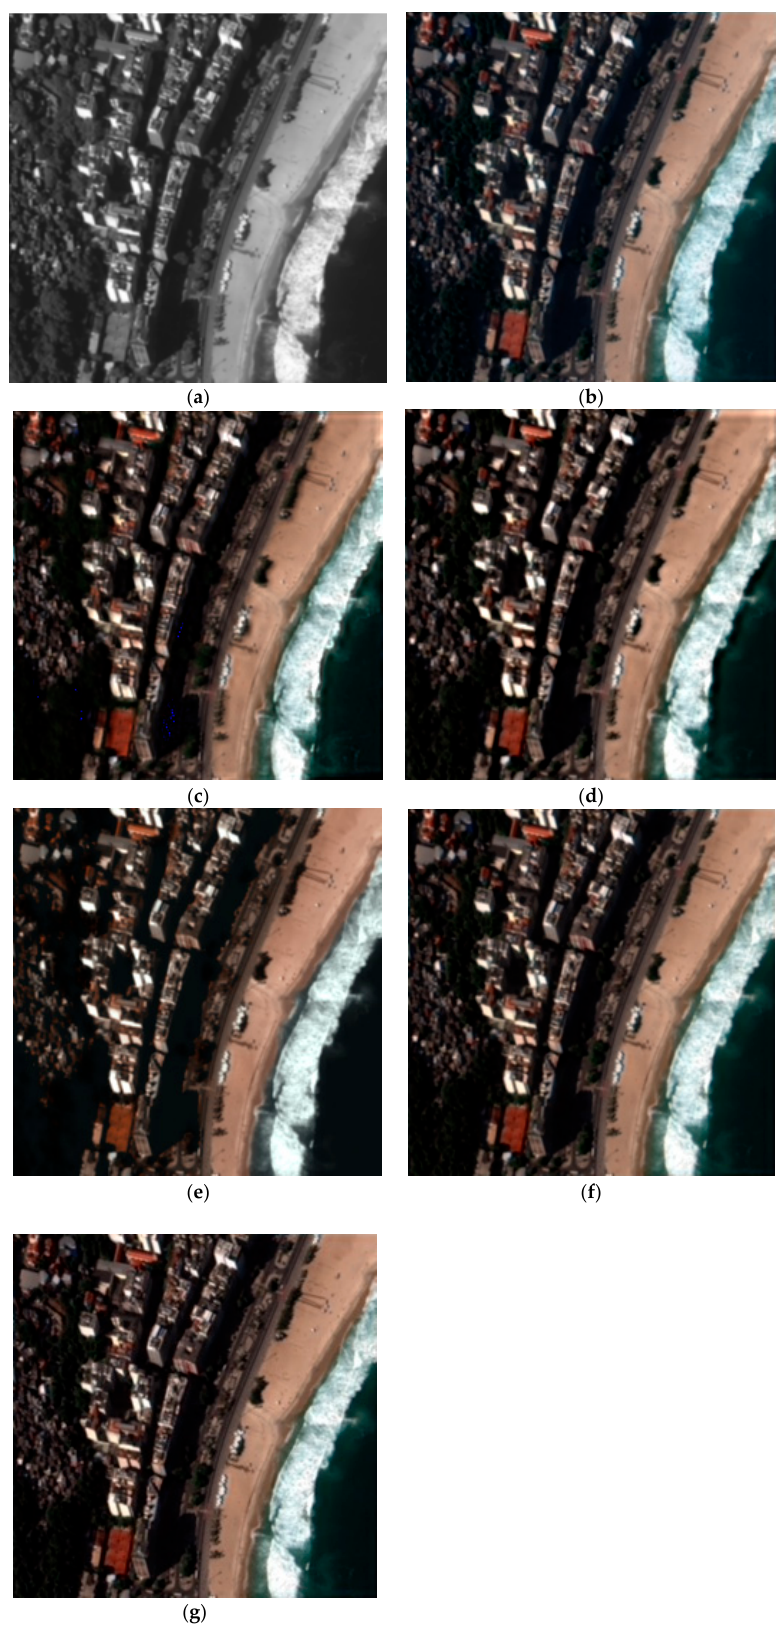
Figure 9. Real-data results for the Worldview-2 dataset. ( a ) Original PAN; ( b ) PCA; ( c ) SFIM; ( d ) MTF-GLP; ( e ) PNN; ( f ) DiCNN; ( g ) proposed.